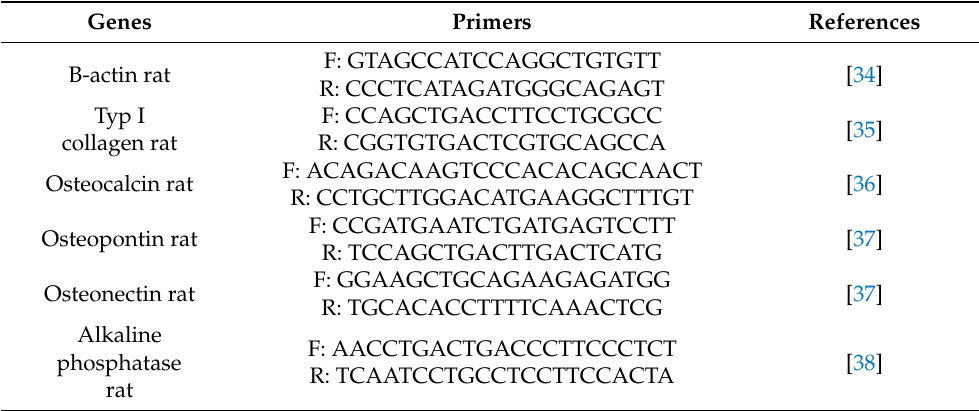
Table 1. Forward (F) and reverse (R) primers of genes used for RT-PCR experiments. Genes